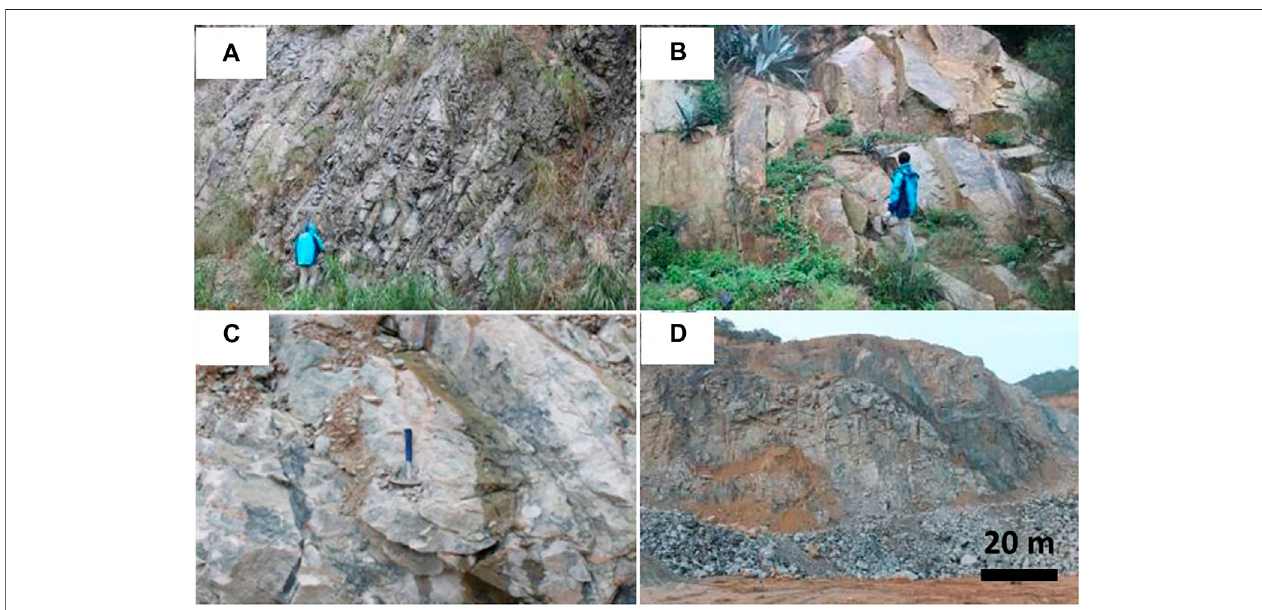
FIGURE4 | Photograph showing outcrops of granitesin different areas, (A) granite outcrop withfracturesin Minhou,Fuzhou area; (B) granite outcrops in Qinqian, Fuzhou area; (C) granites with fractures in Huizhou; (D) granites in Zhangzhou.